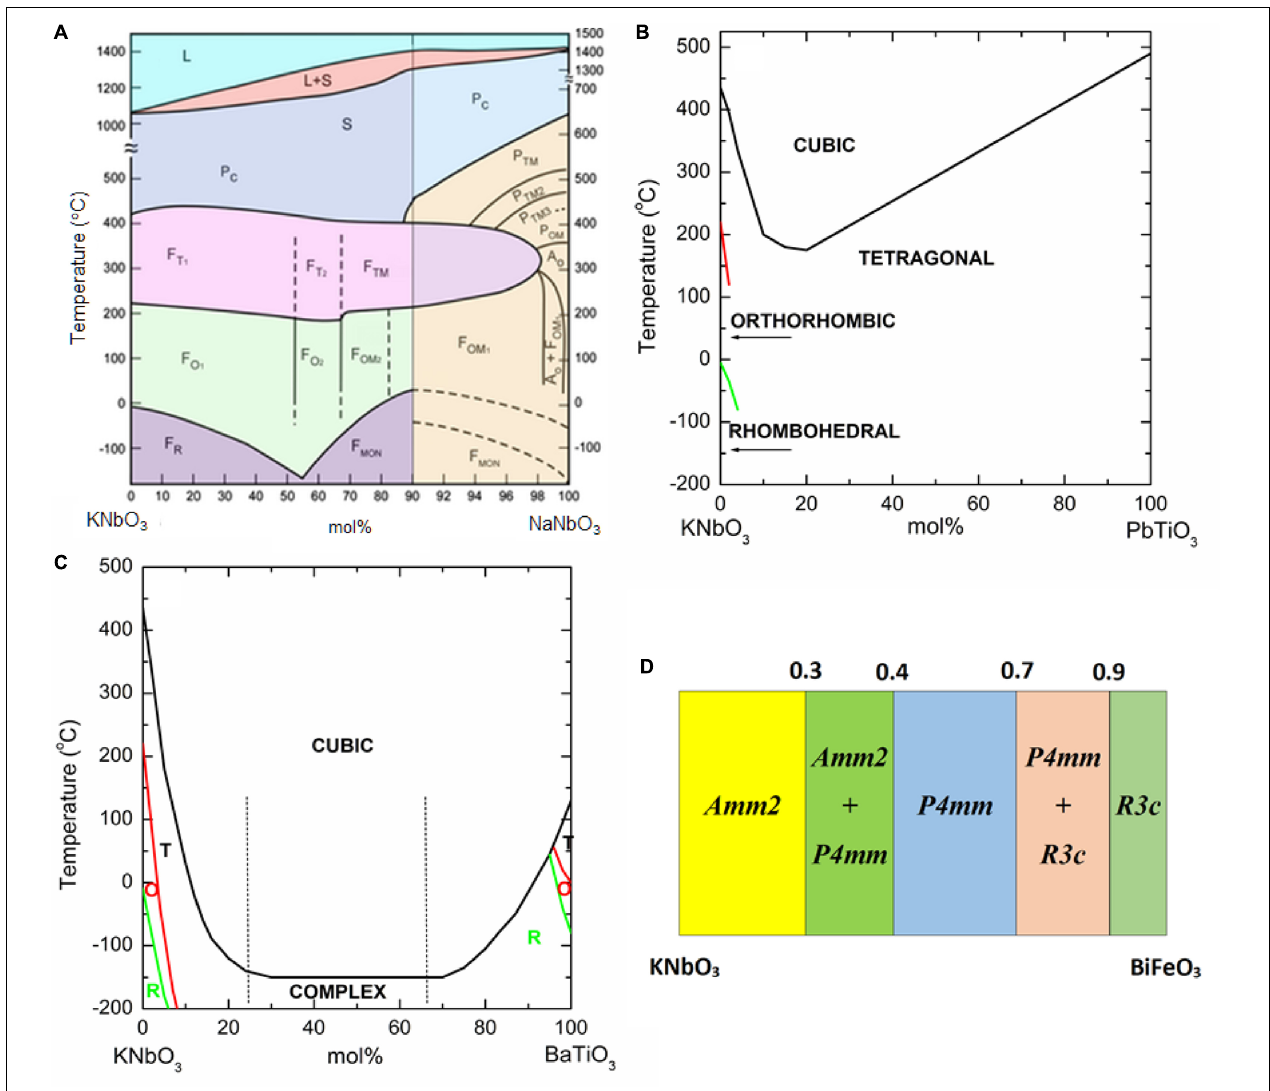
FIGURE 7 | Phase transition temperatures in the (A) KNbO 3 -NaNbO 3 , (B) KNbO 3 -PbTiO 3 , (C) KNbO 3 -BaTiO 3 systems and (D) room-temperature symmetry in the KNbO 3 -BiFeO 3 system. T, tetragonal, O, orthorhombic, R, rhombohedral [Redrawn from Shirane et al. (1954b), Tien et al. (1962); Bratton and Tien (1967), Lennox et al.